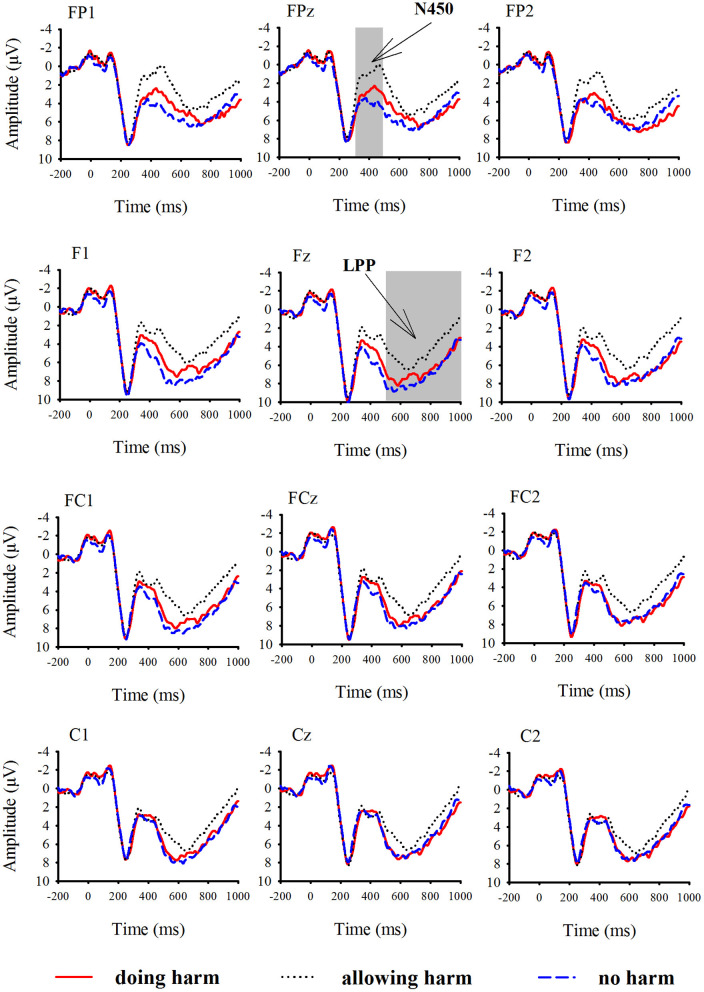
Grand-averaged event-related potential waveforms for doing harm (red lines), allowing harm (black dot lines), and no harm (blue dash lines) conditions at 12 electrodes.